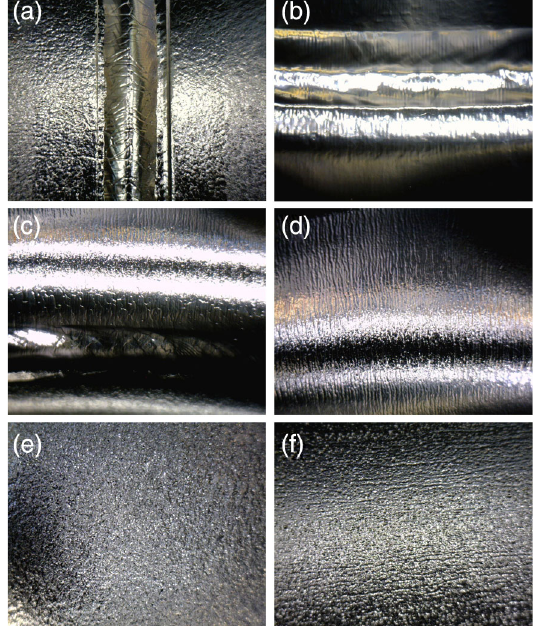
FIG. 14. Typical surface morphologies after substantial VEP ( > 100 μ m) at different locations of the cavity. The weldings at (a) equators and (b) irises are smooth. Stripes caused by bubbles are observed at the proximity of irises (c) and (d). In the areas between equators and irises (e). the surface is rougher. Some pitting occurred during the uncontrolled VEP sequence (f). The width of the each view is approximately 20 ( π -mode) the measured Q 0 at low accelerating gradient (below 1 MV = m) was 2 × 10 9 at 1.5 K, which is approx- imately 10 times lower than expected. When increasing the gradient up to 6 MV = m the Q 0 decreased quickly down to 5 × 10 8 , with a dissipated rf power of 150 W in the cavity.